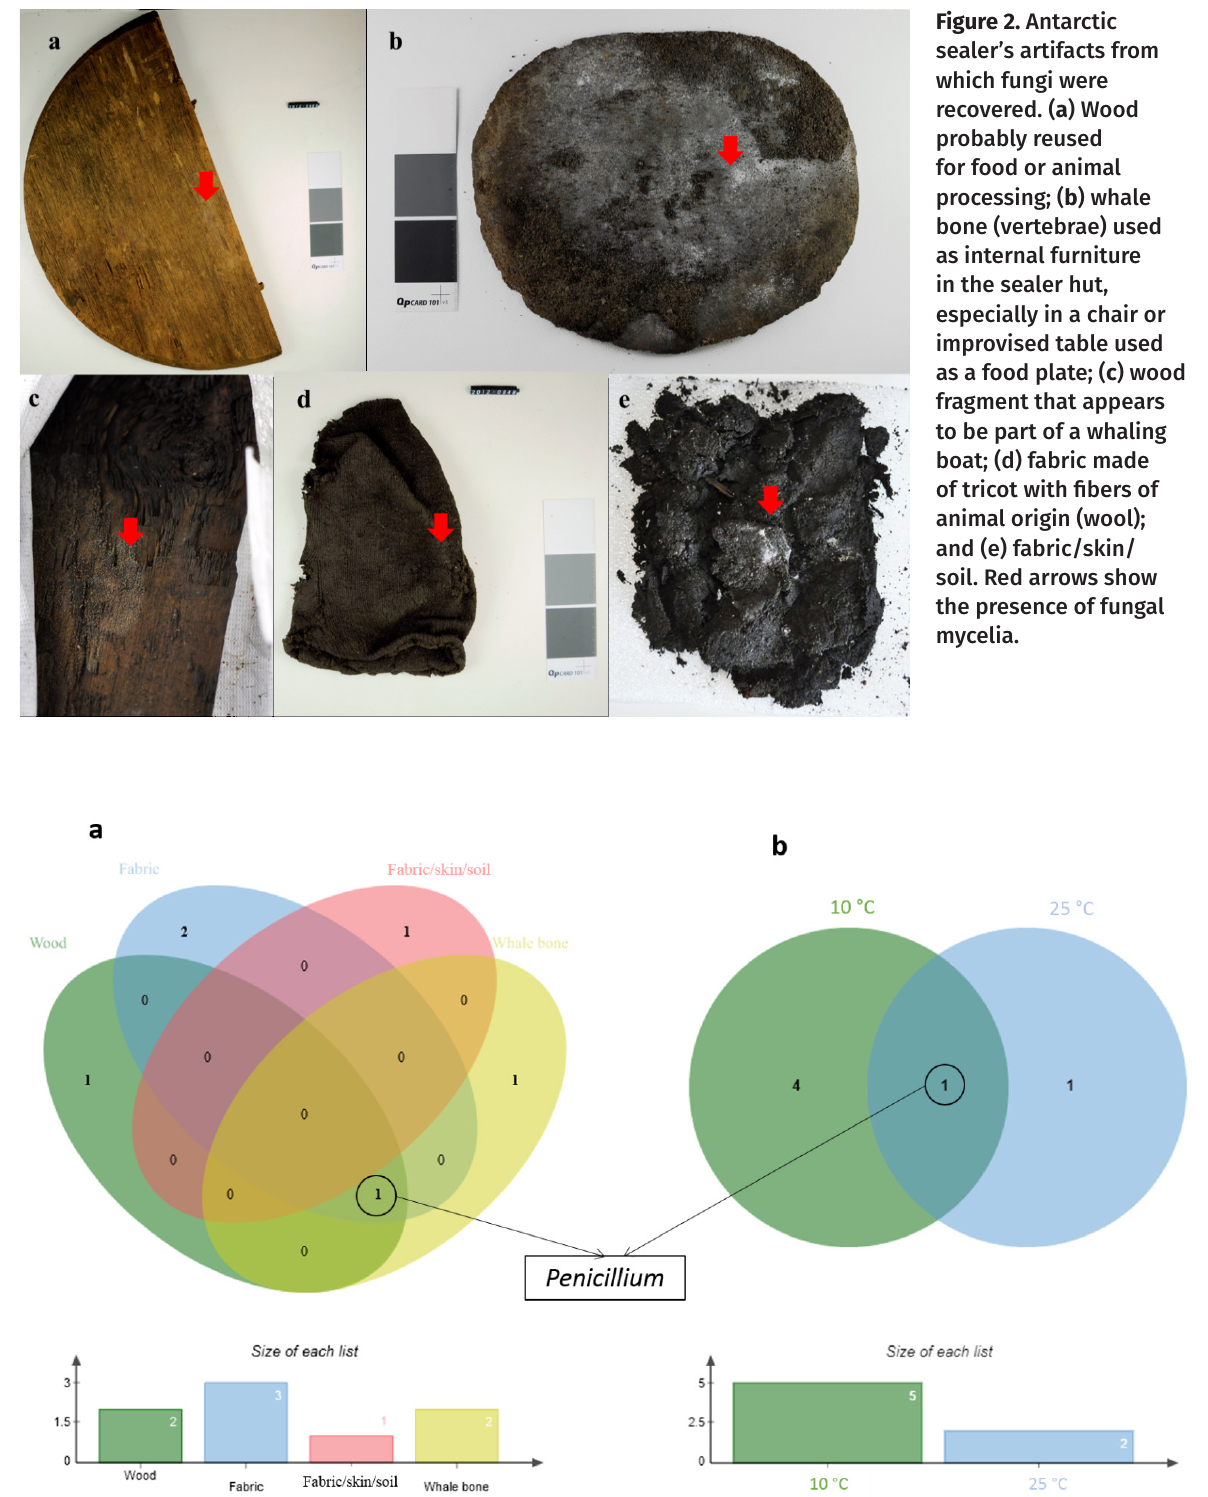
Figure 3. Similarities of fungal genera detected on the different ( a ) archaeological sealer’s Antarctic artifact materials and ( b ) artefact storage